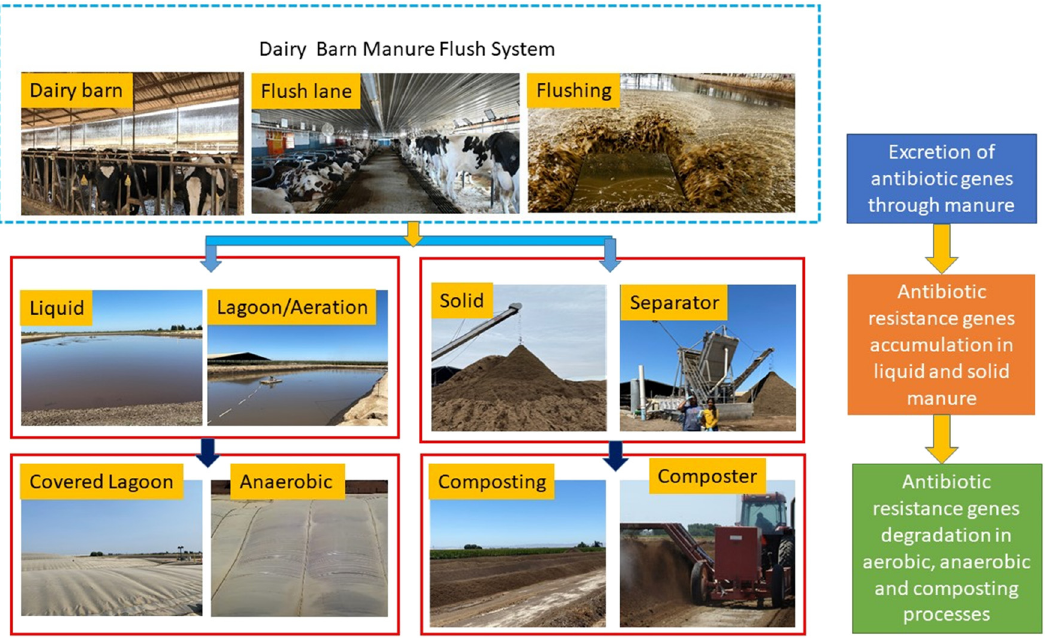
Figure 3: Dairy manure management system and dairy waste management technologies for controlling the dissemination of ARGs into